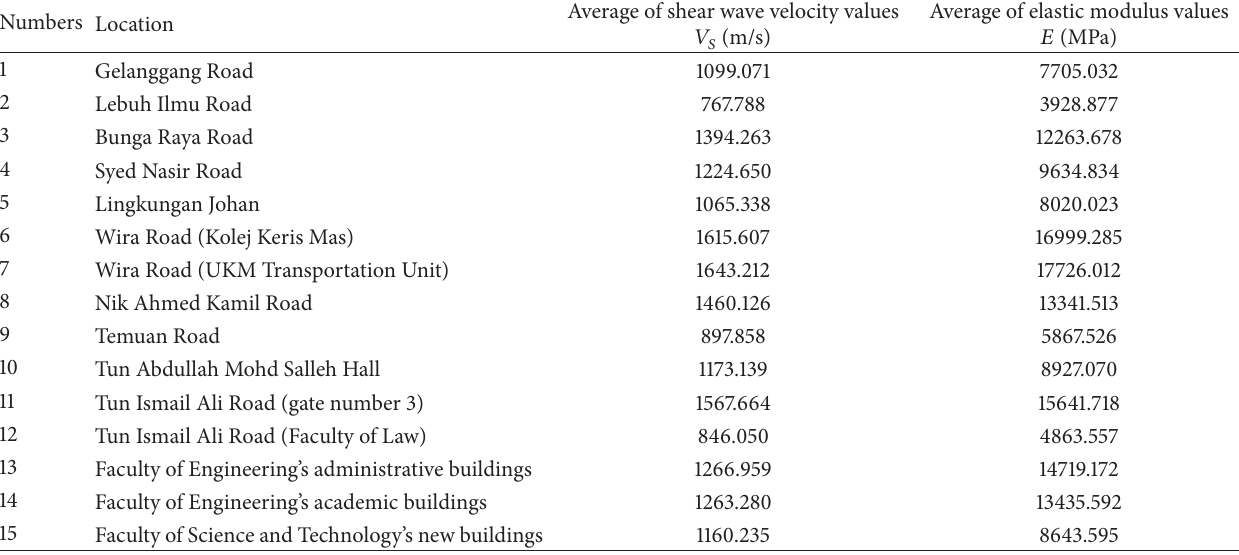
Table 2: Average of shear wave velocity and elastic modulus values.